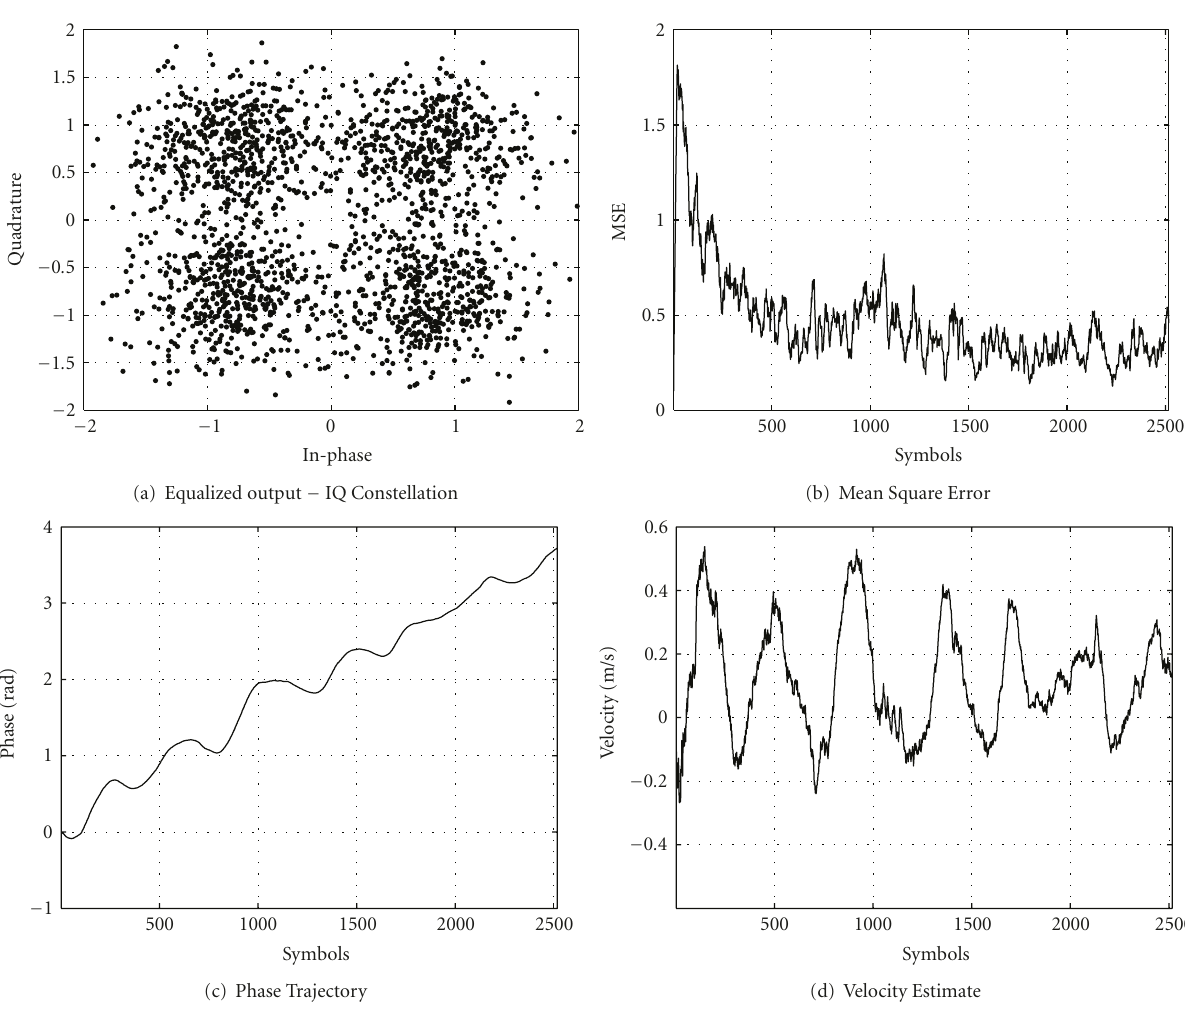
Figure 12: Performance of the proposed receiver after 1st